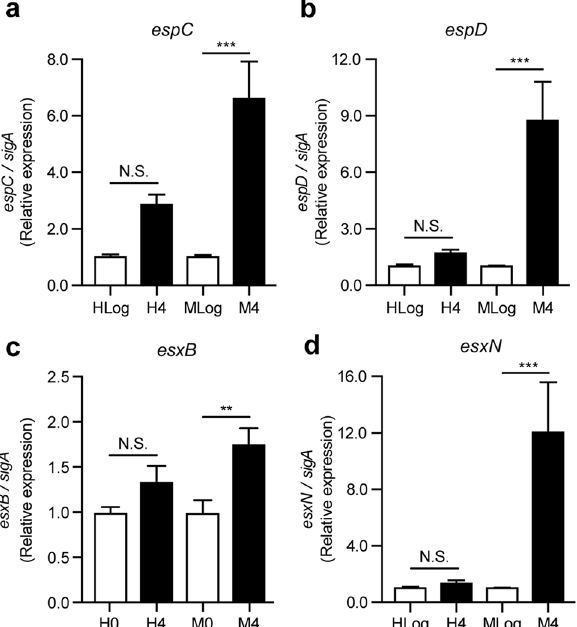
Figure 6. Expression levels of genes involved in the ESX-1 secretion system: espC , espD , esxB , and esxN . ( a–d ) THP-1 macrophages were infected with the M. tuberculosis reference strain H37Rv (H) or the MKR superspreader (M) for 4 h. The expression levels of various genes involved in the ESX-1 secretion system were quantified by qRT-PCR. 2 -∆∆ct is used for normalisation and relative quantification. One-way ANOVA with Tukey’s multiple comparison test was used to determine which pairs of expression levels were significantly different (*: p < 0.05; **: p < 0.01; and ***: p <